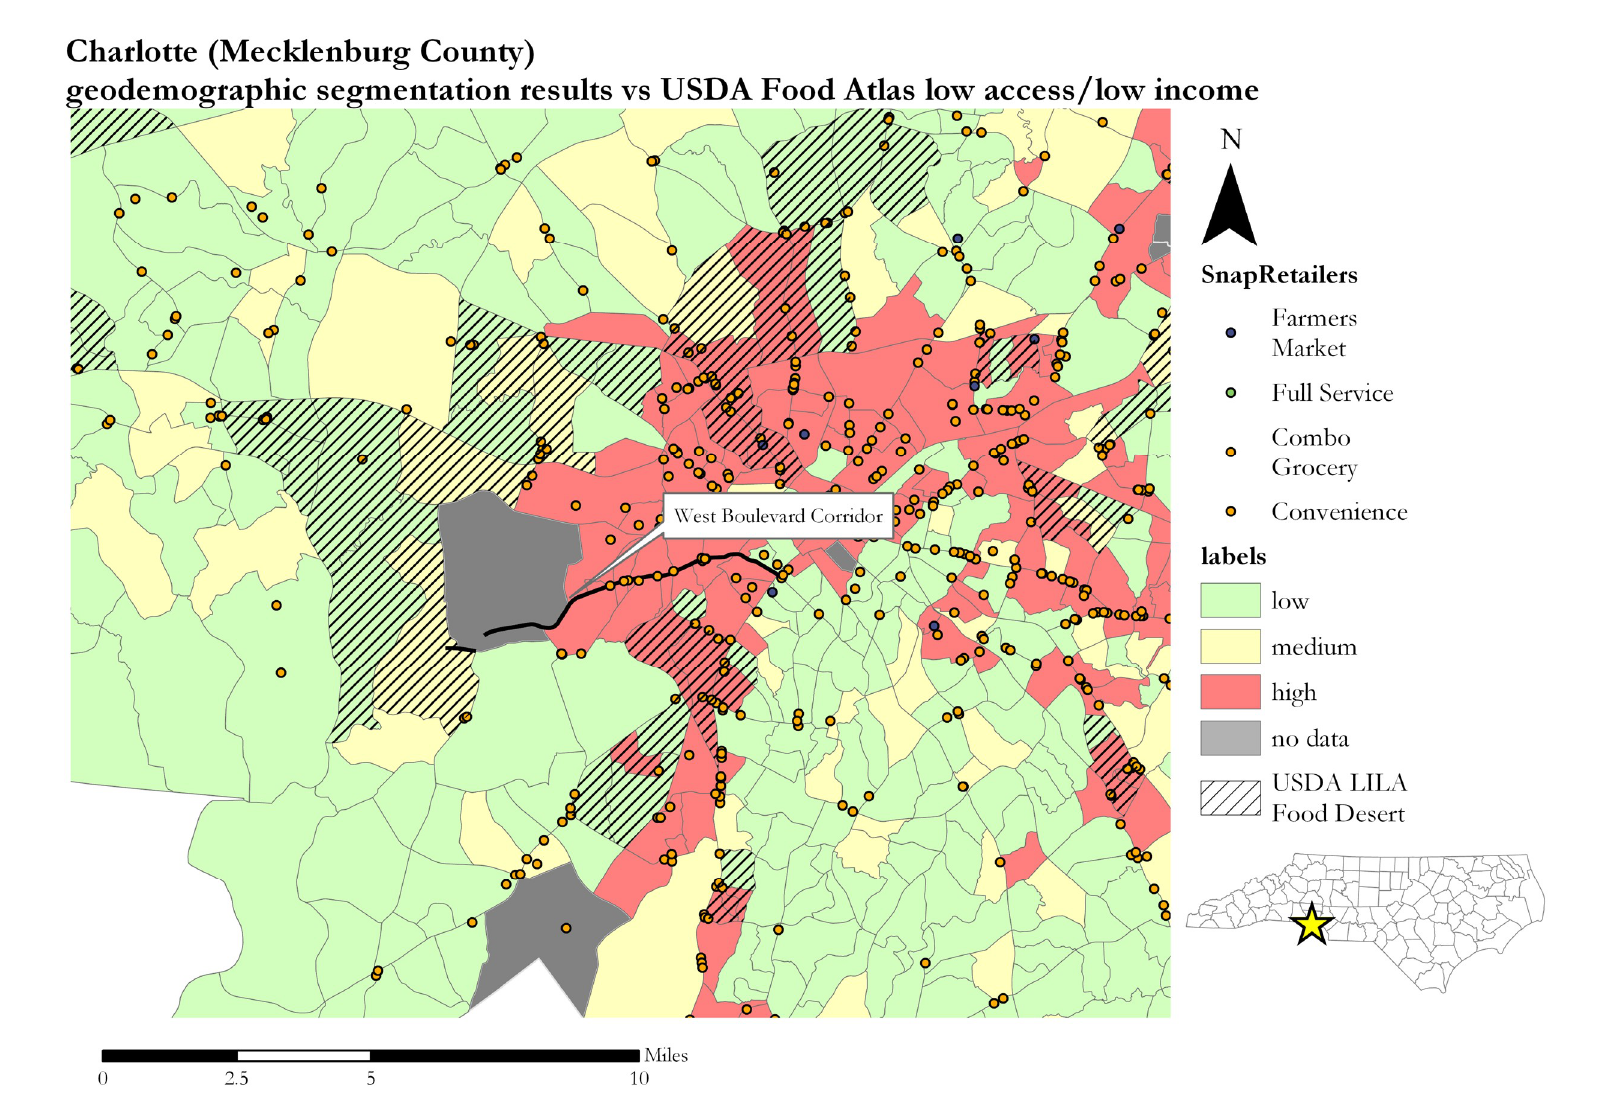
Figure 9. Charlotte (Mecklenburg County) geodemographic segmentation results vs USDA Food Atlas low-access/low-income areas.